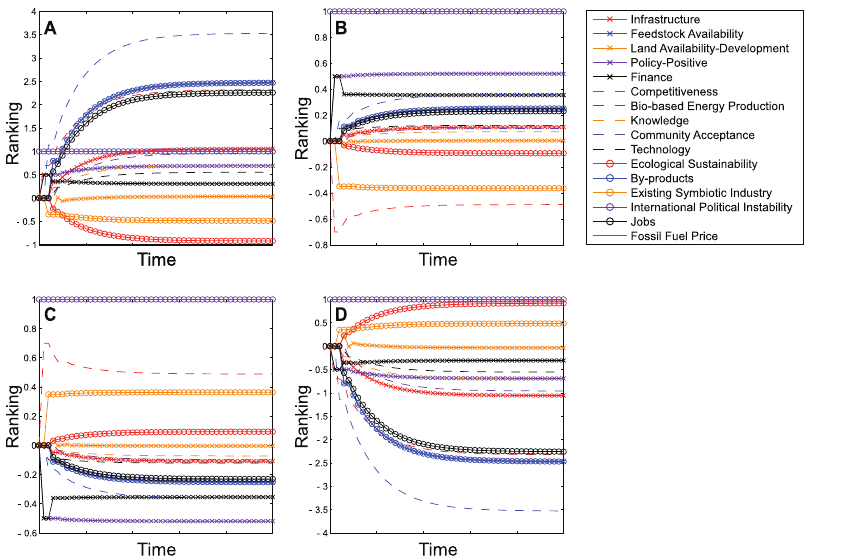
Figure 2. Output of the linear model of the FCM from the first workshop. a) Output from graph as drawn by participants, b)output showing the effects of reversing the effects of fossil fuel price alone, c) political instability alone and d) both fossil fuel price and political instability.